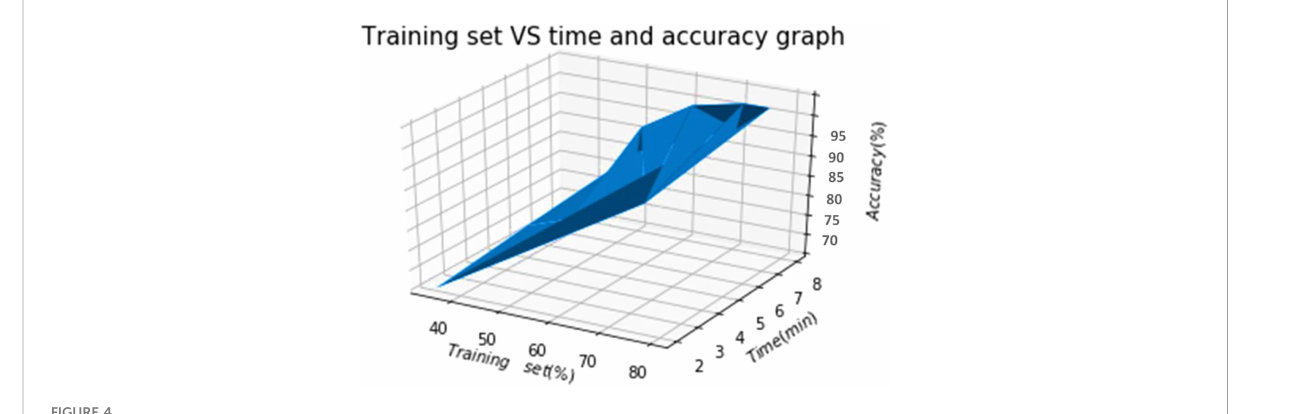
FIGURE 4 Recognition abilities based on varying training and test